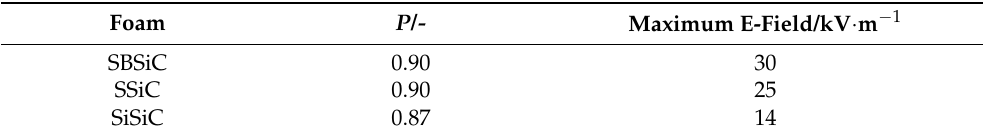
Figure 6. Example of the 3D maximum electric field distribution in the tube at the foam’s core (SBSiC, 30 ppi). Table 3. Maximum electric field strength in the foams for concentrating the electric field distribution to the foam’s core.